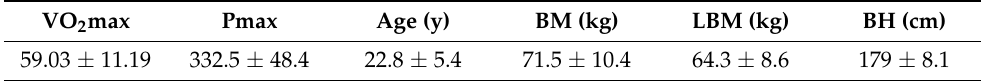
Table 1. Physiological and anthropometric characteristics of the